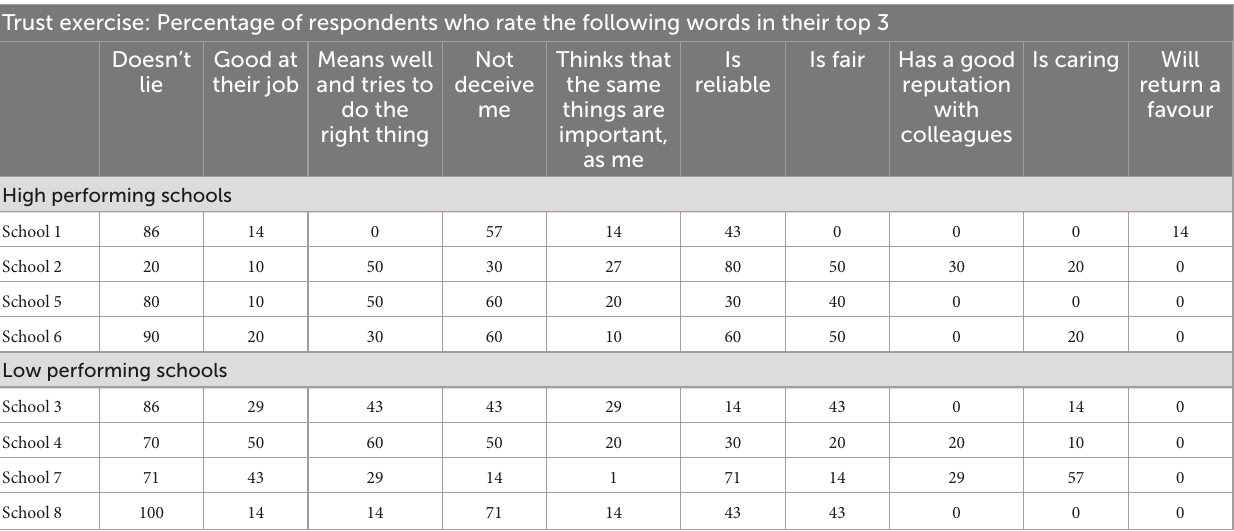
TABLE 1 Summary of trust